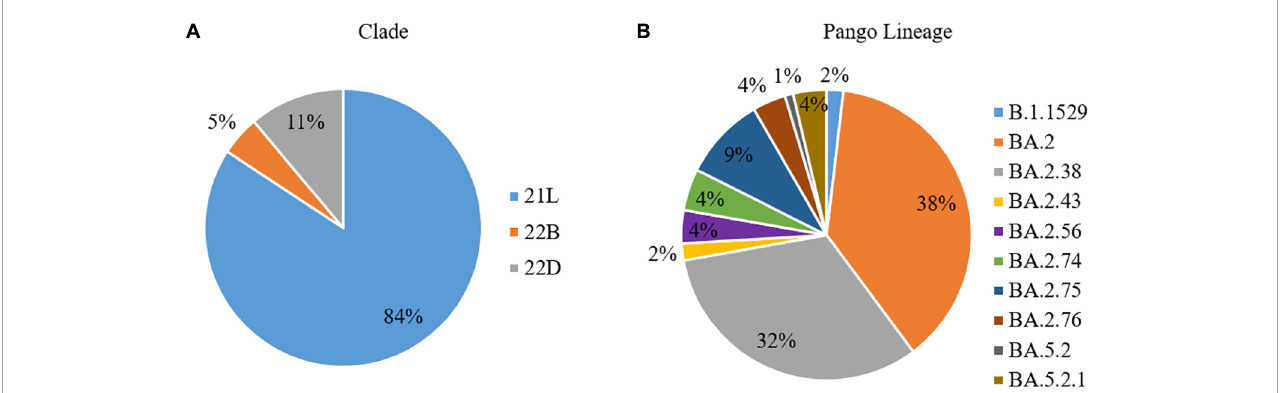
FIGURE1 Spectrum of the whole-genome sequences of SARS-CoV-2 ( N = 108), in terms of (A) Clades and (B) Pango Lineage, from patients of the state of Chhattisgarh.